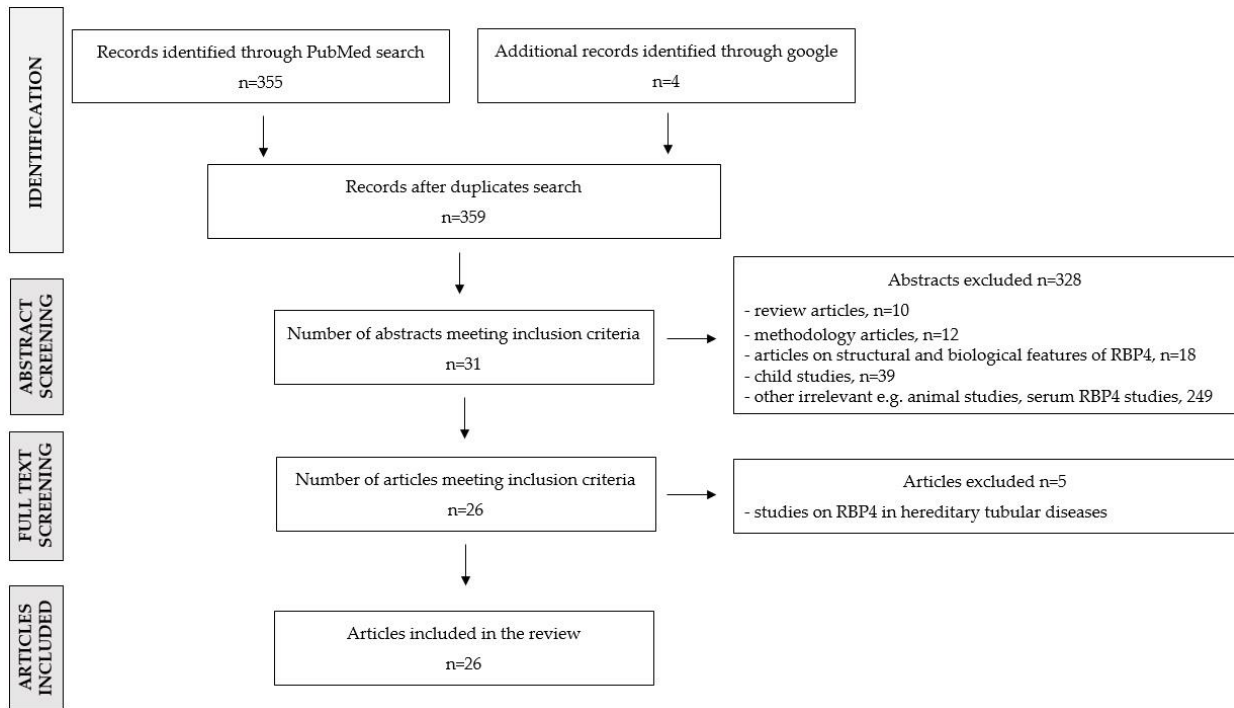
Figure 1. Flowchart of the literature selection process.